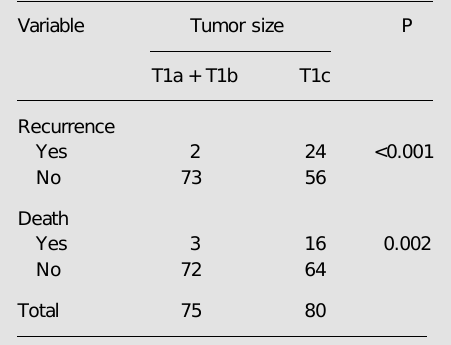
Table 3. Relationship between tumor size and follow-up status of 155 patients with infiltrating T1N0M0 ductal carcinomas.